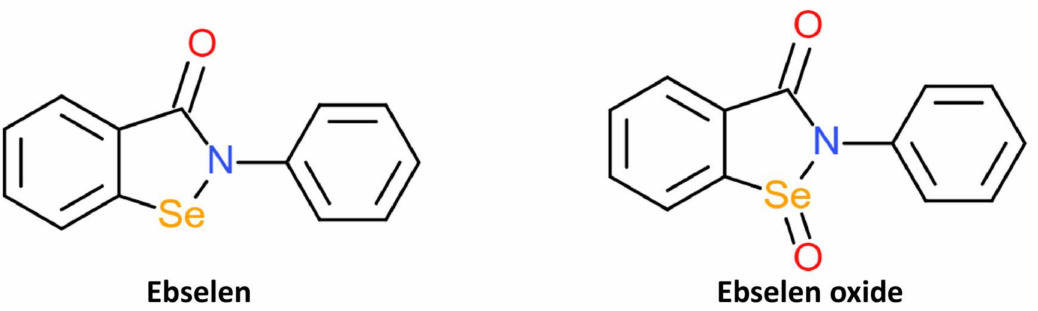
Figure 6. Structures of HDAC inhibitors ebselen and its oxidised derivative, ebselen